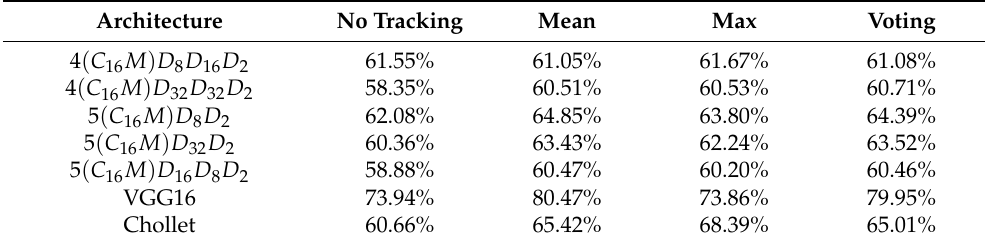
Table 3. Accuracy of the binary classification task with and without the tracking component. The Mean , Max and Voting columns refer to the type of decision scheme used when the tracking mechanism is applied. The dataset is divided into train, validation, and test subsets as shown in Table 2, but with the species aggregated into two classes: (1) Seriola dumerili and Coryphaena hippurus , and (2) Thunnus alalunga , Xiphias gladius , Scomber scombrus and Trachurus mediterraneus . The results shown are the mean of 3